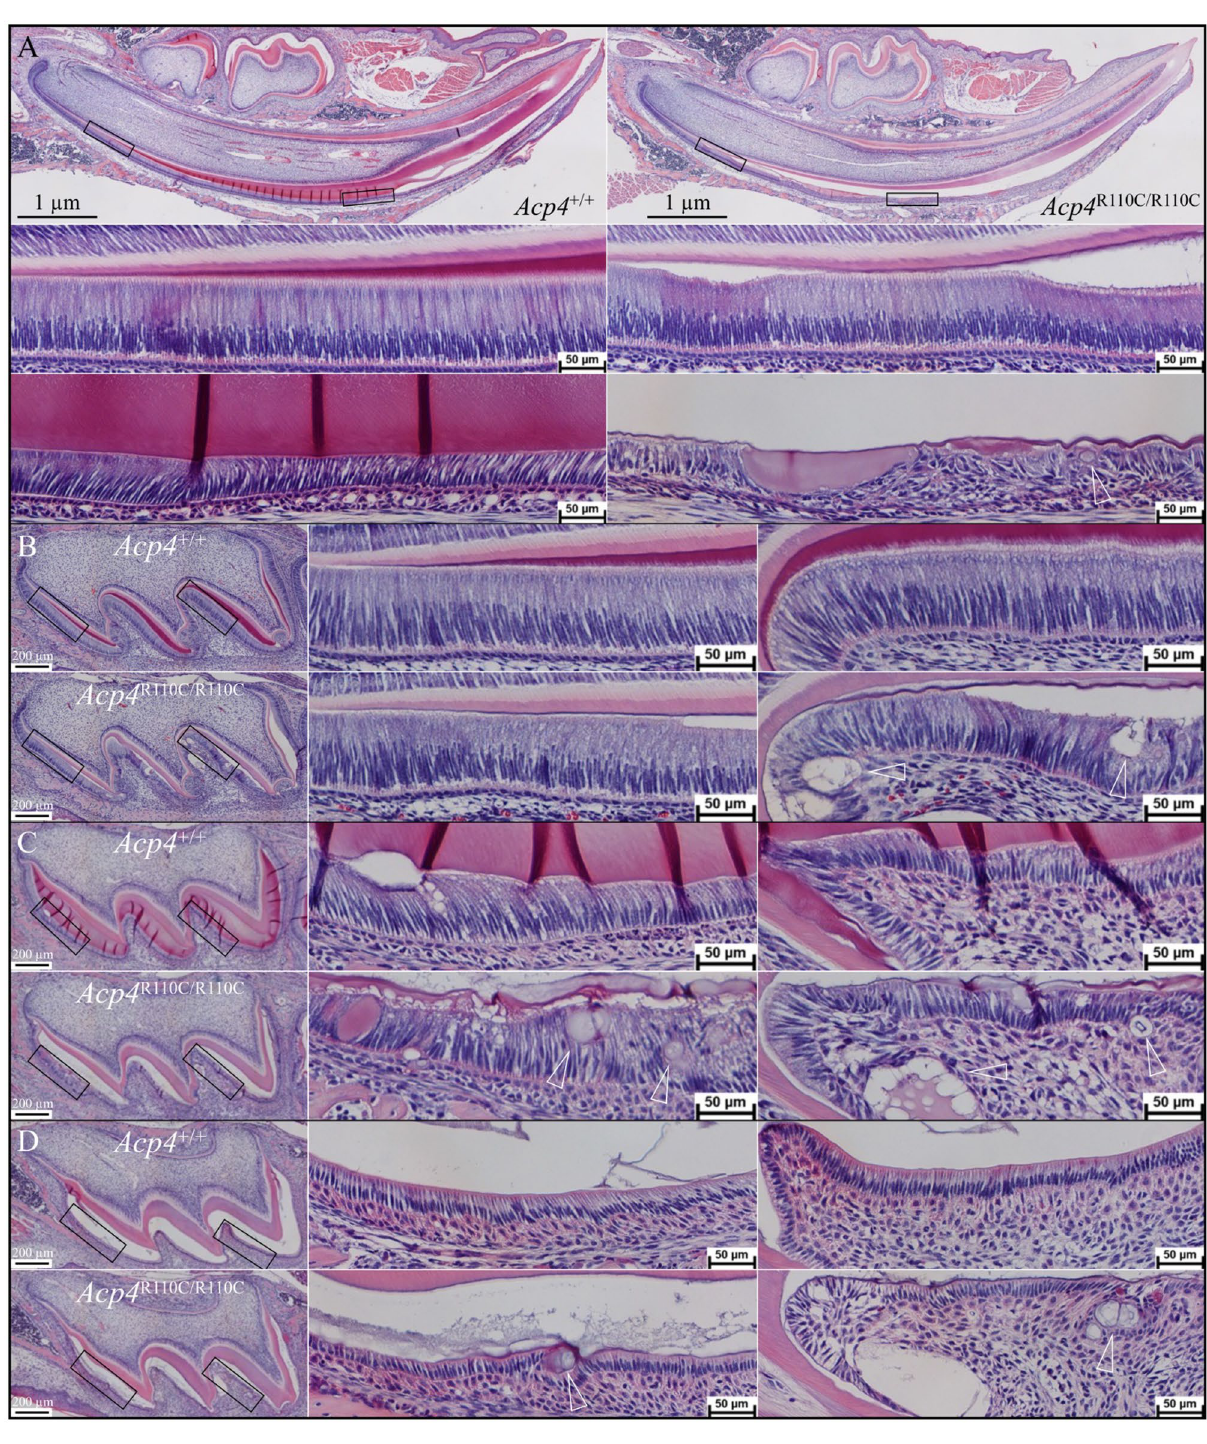
Figure 8. Histology of Sagittally Sectioned, H&E Stained, Developing Incisors and Molars from Acp4 +/+ and Acp4 R110C/R110C Mice. ( A ) Histology of D12 mandibular incisors. Top: sections through Acp4 +/+ (left) and Acp4 R110C/R110C (right) hemimandibles (40×). Black rectangles outline positions of higher magnification (200×) images shown below, covering the initiation of enamel formation (middle) and post-secretory transition (bottom). Note that in Acp4 R110C/R110C mice no proper enamel matrix is formed. Ameloblasts detach but remain polarized during the secretory stage (middle), but progressively degenerate as pathological ectopic mineral nodules (arrowhead) form in the soft tissue. ( B – D ) Histology of D4 ( B ), D8 ( C ), and D12 ( D ) Acp4 +/+ and Acp4 R110C/R110C maxillary first molars. Left: whole molar sections with black rectangles outlining ameloblasts on the mesial and distal cusps shown at higher magnification (200×) toward the right. As in the incisors, in Acp4 R110C/R110C molars no proper enamel formation was observed. Ameloblasts polarized but detached from the mineral surface, ectopic mineral nodules formed (arrowheads) and expanded, and cell pathology worsened with